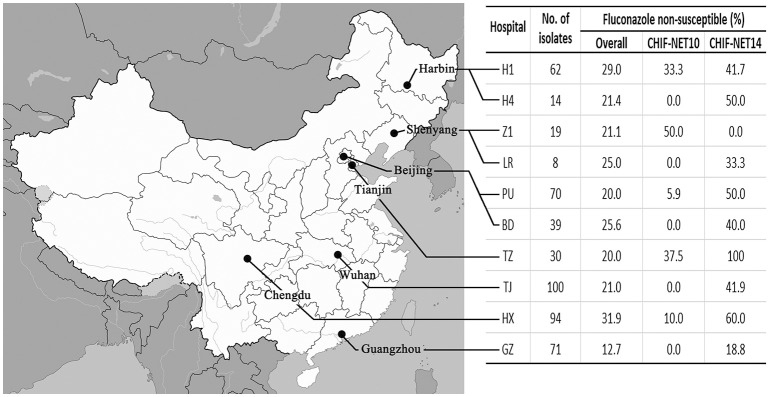
Geographic distribution of the 10 surveillance centers involved in this study, number of isolates collected, and change of fluconazole non-susceptible rate from the first to the last surveillance year in each center.